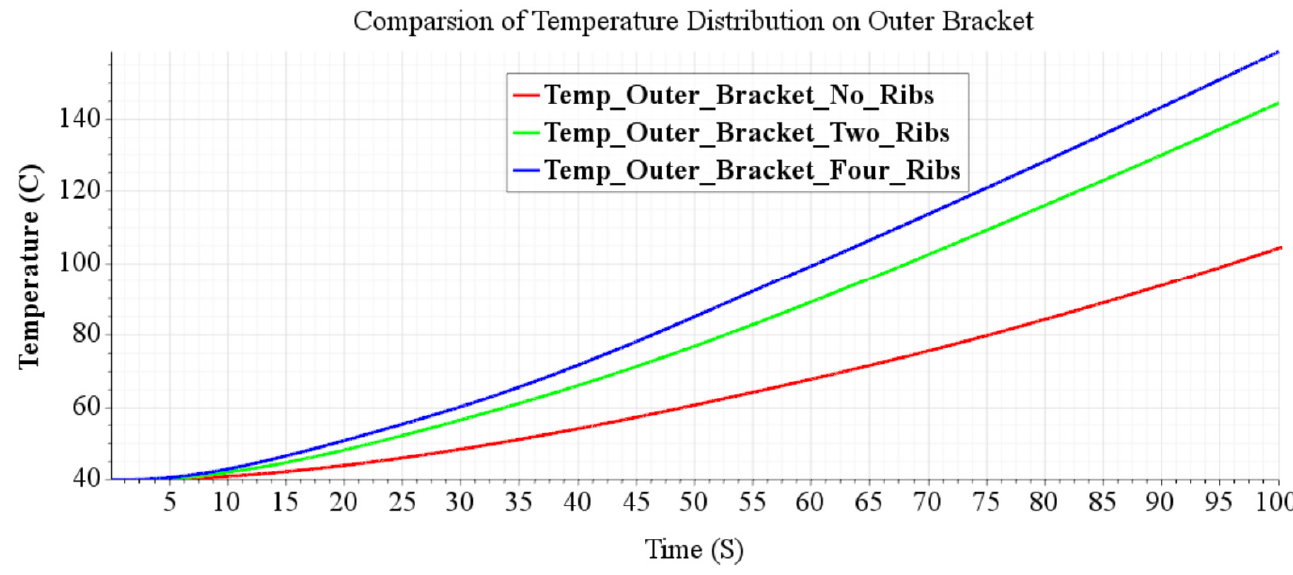
Figure 15. The outer bracket temperature change with function of time for four rib configuration.